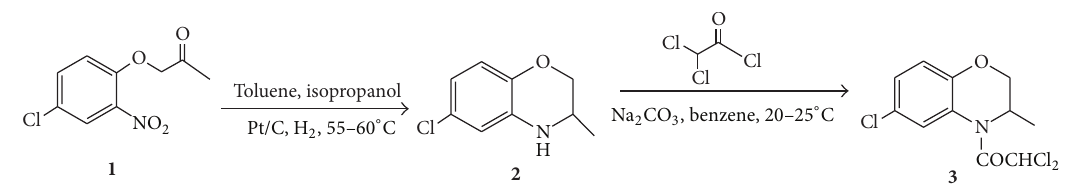
Scheme 1: Procedure of preparing the title compound.